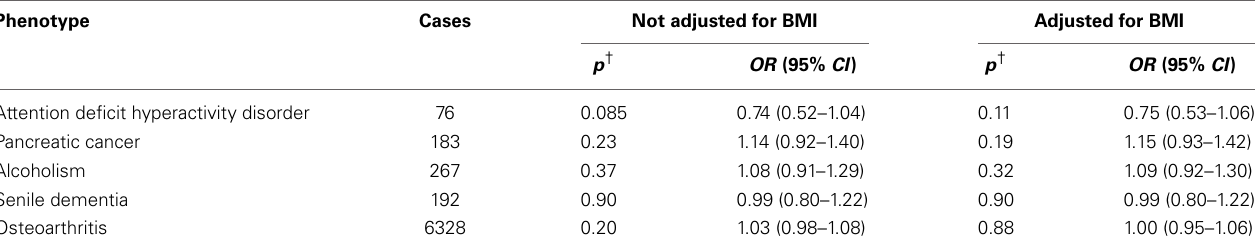
FIGURE 3 | PheWAS plots for other obesity associated SNPs in low LD with rs8050136. These plots show values without adjustment for BMI (shown as triangles) and with adjustment for average BMI (shown as dots) plotted on the same axis. (A) rs6499640 is in both datasets with a lower LD with rs8050136 ( r 2 = 0 . 06) and has a different phenotype pattern than rs8050136 (B) rs16952520 is only present in the eMERGE population and has low LD with rs8050136 ( r 2 = 0 . 03) and while not strongly associated with